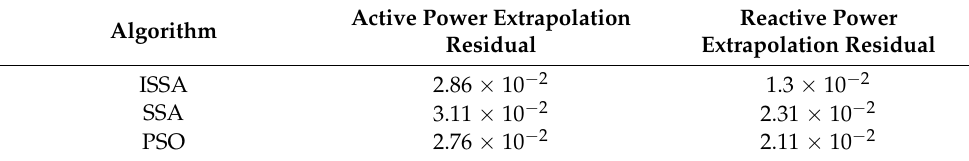
Table 5. Extrapolation response residual.